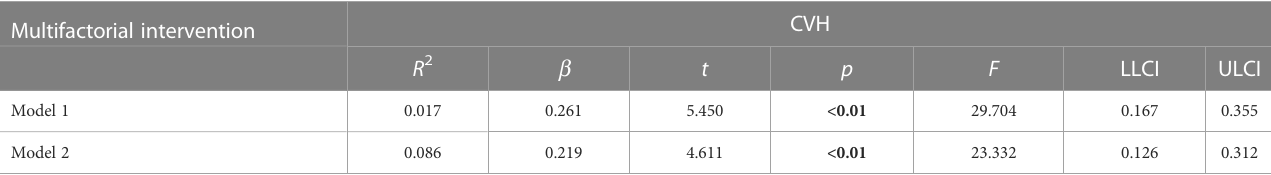
TABLE 5 The multilevel linear regression between CVH and multifactorial intervention (behavioral, diet, drug treatment, and weight management). Multifactorial intervention CVH R 2 b t p F LLCI ULCI Model 1